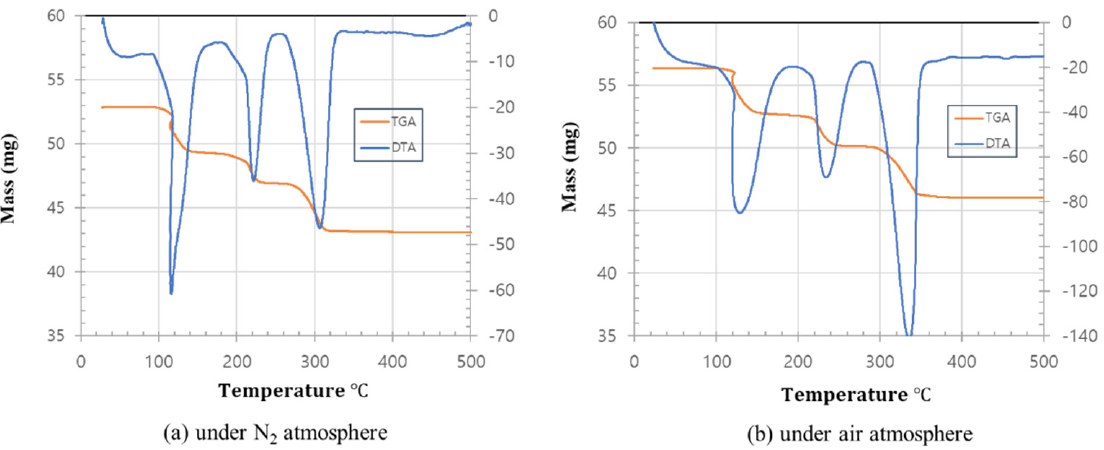
Figure 1. TGA and DTA results for the thermal decomposition of ammonium molybdate ( a ) under N 2 atmosphere, ( b ) under air atmosphere.